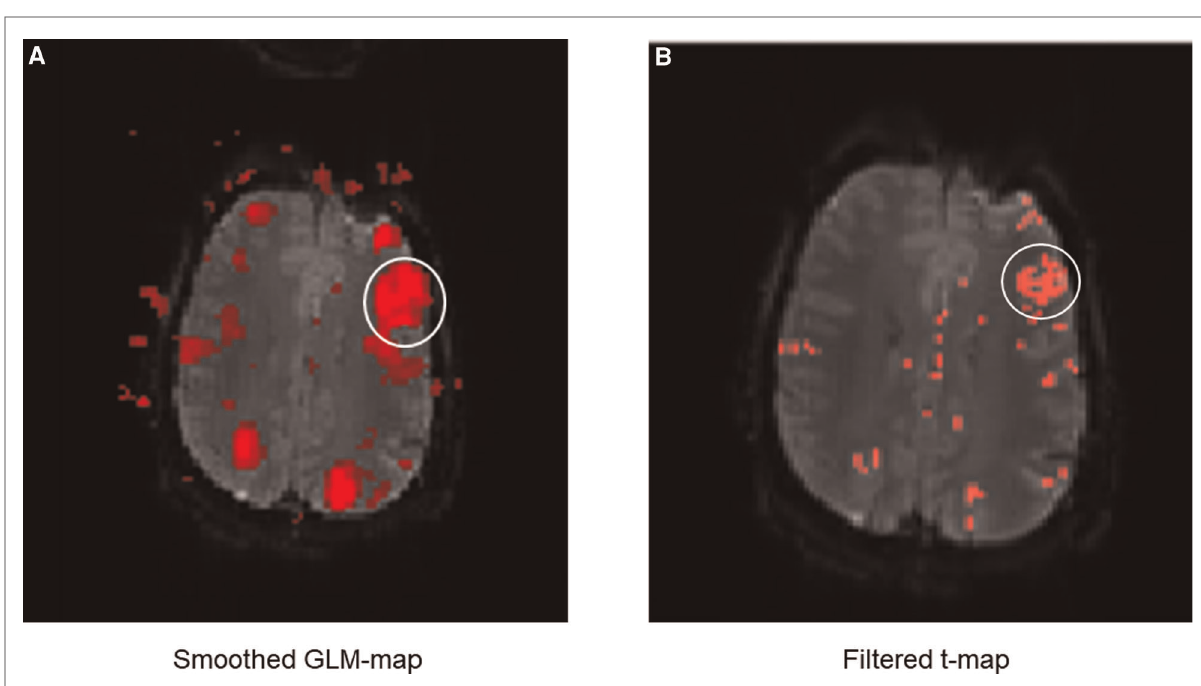
FIGURE 8 Exemplary comparison of the display of LAs between the GLM map ( A ) and the fi lter t -map ( B ). The white circle marks Broca ’ s area. It can be noticed that the display of Broca ’ s area is displayed much larger on the GLM map than on the fi lter t -map, even though the same fMRI data were used. This is mainly due to the smoothing of the GLM maps, causing surrounding activations to merge into the language activations (in this case of Broca ’ s area). This can lead to differences between the displayed and truly measured spatial boundaries of the LAs. The presence of directly adjacent and merging activations complicates the evaluation and the exact localization of the LAs and was incorporated as a negative aspect in the evaluation of the activation maps. The display of Broca ’ s area on the fi lter t -map ( B ) in comparison is smaller, distinguishable from sur-rounding activations and shows only the truly measured activations and spatial boundaries of activations.